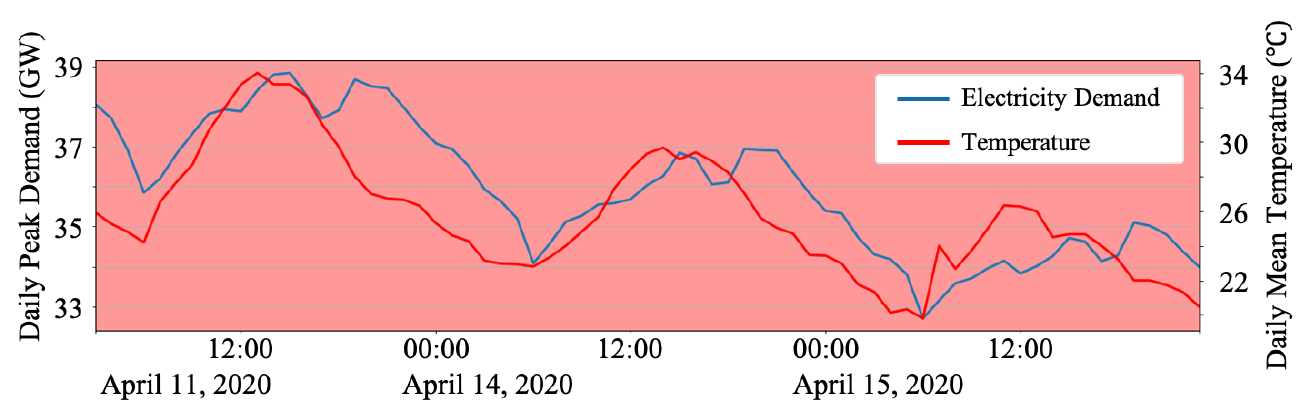
Figure 6. Electricity demands and temperatures from 12–14 April 2020, during full curfew.